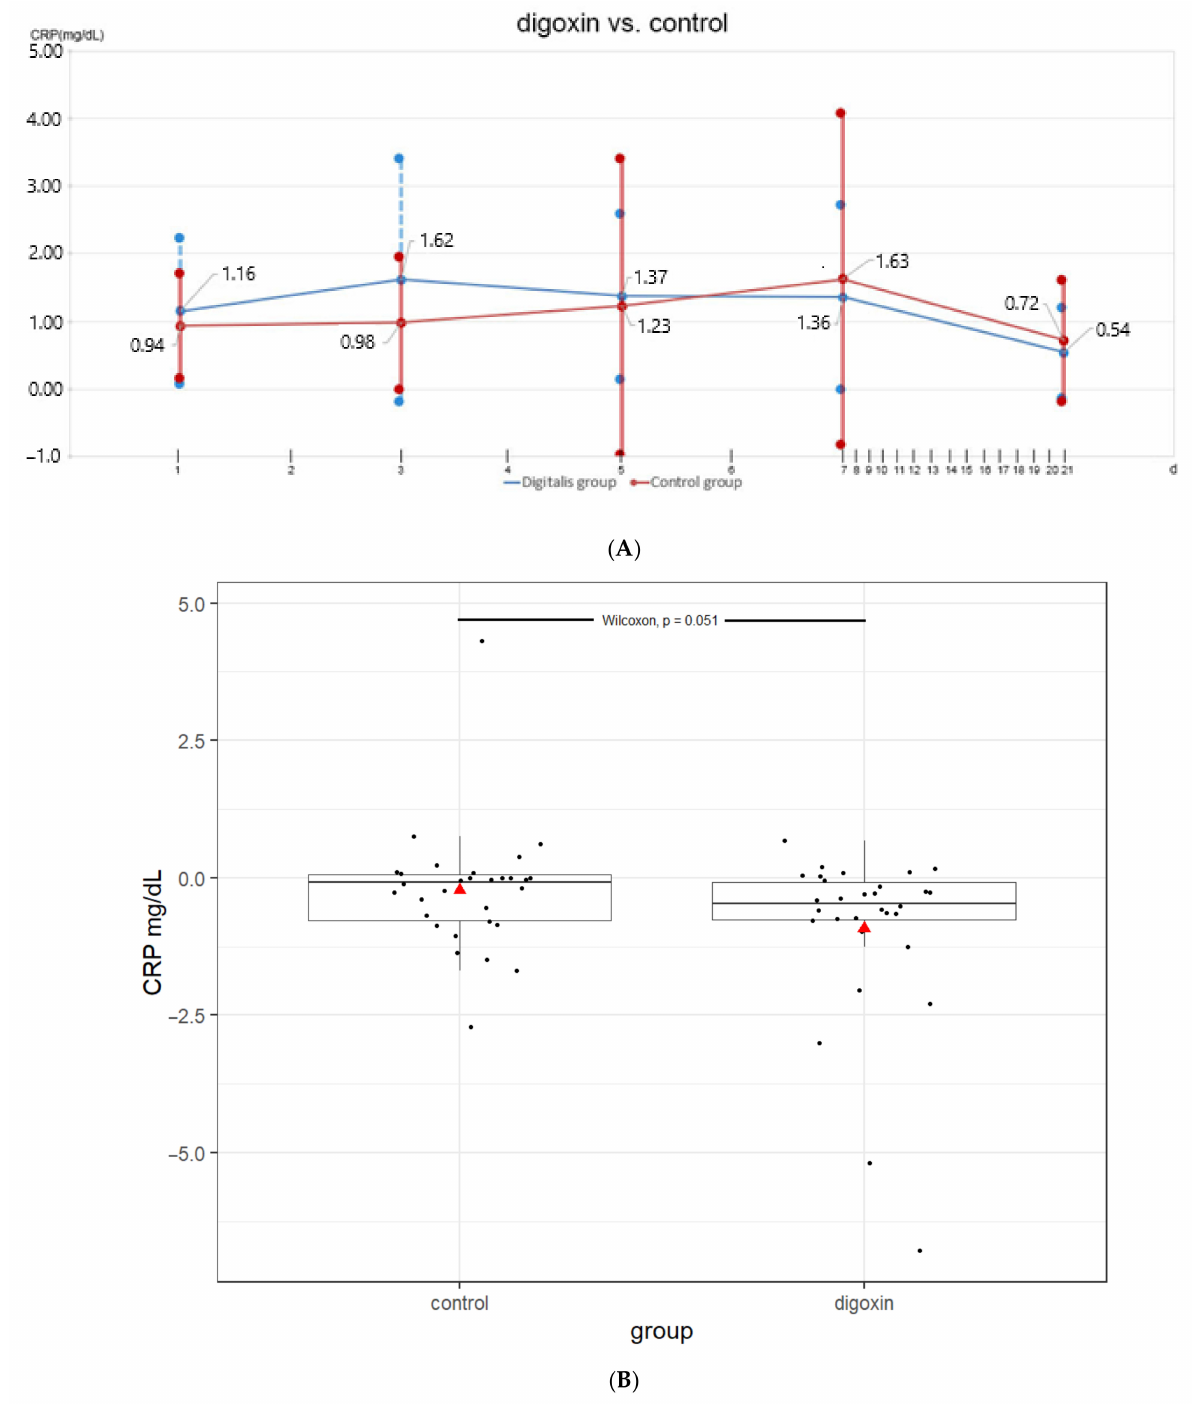
Figure 1. ( A ). Course of mean CRP levels ± SD in the digoxin group and control group (d1 to d21). ( B ) Difference in CRP levels on d21 vs. d3 in the digoxin and control group (box plot: CRP difference d21 vs. d3 digoxin/control group. Triangle = average value, black line = median, upper thin black line = 75. Quantile, lower thin black line = 25. quantile, p =